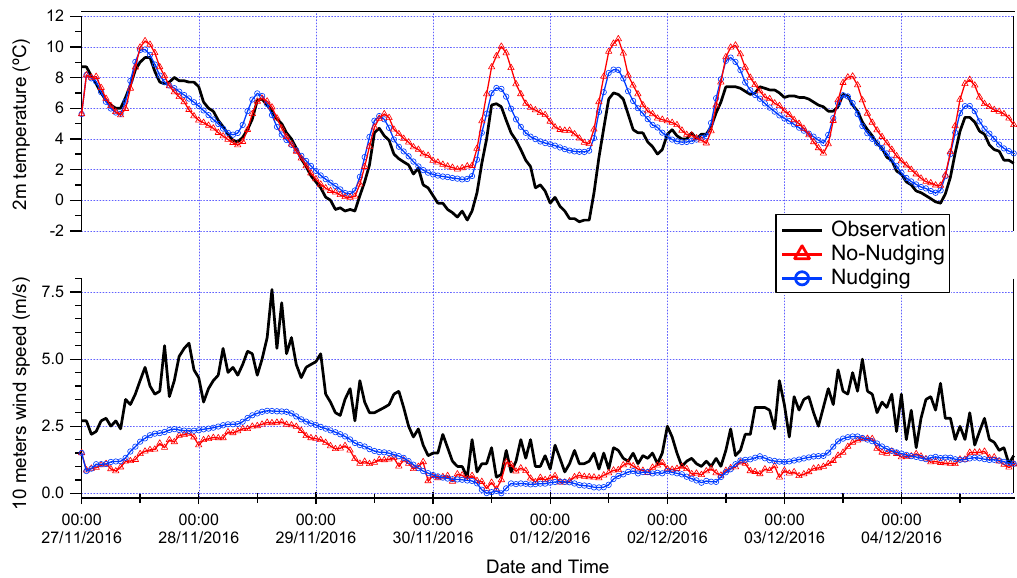
Figure 4. Time series of 2 m temperature and 10 m wind speed at Montsouris station.